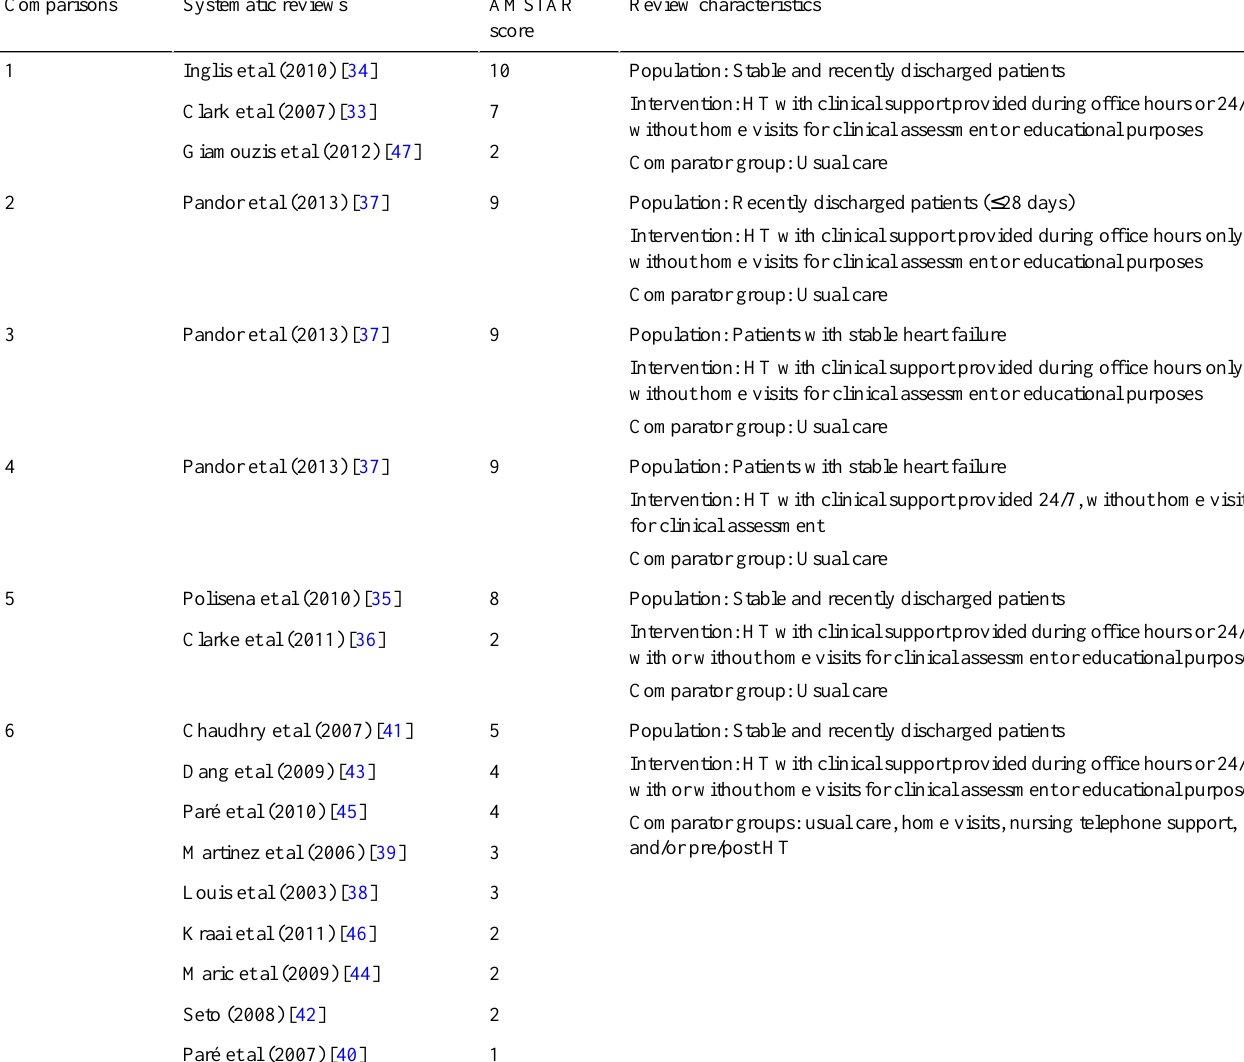
Table 6. Taxonomy of HT systematic reviews according to key elements.